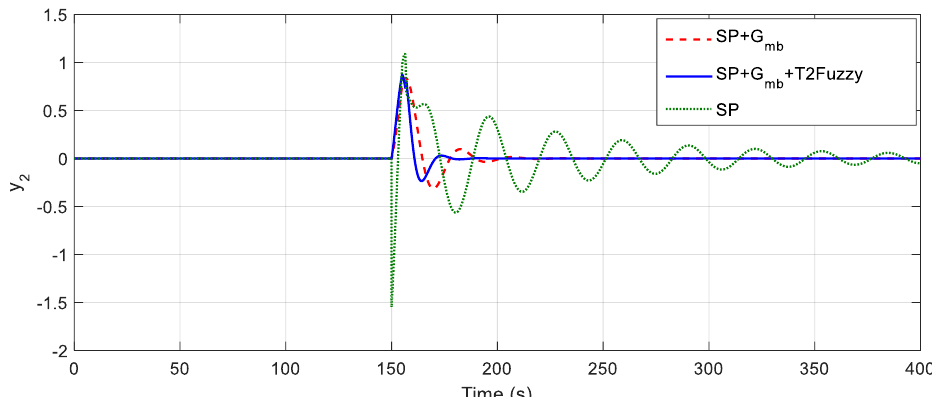
Figure 11. Performance of three control methods for 𝑦 1 by applying disturbance.